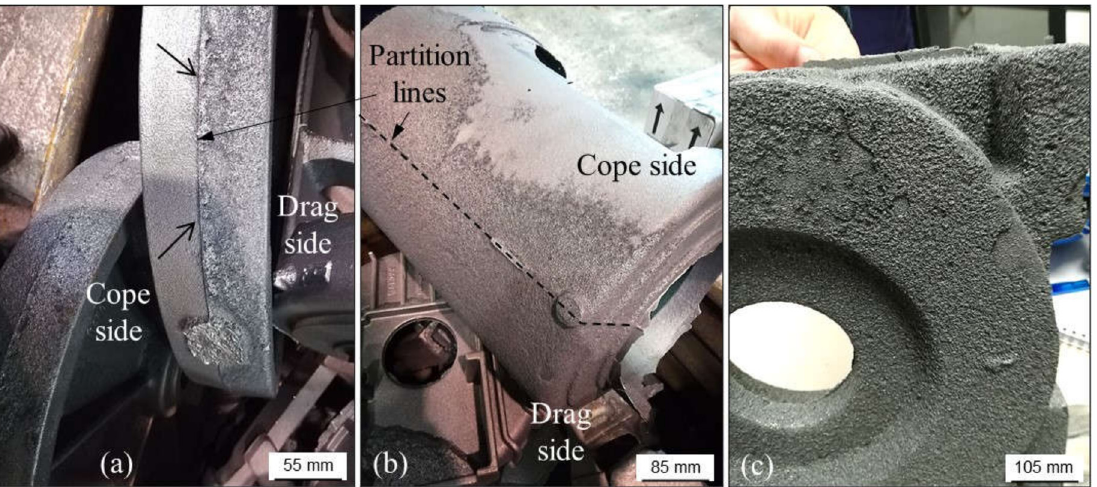
Figure 19. Explosive penetrations in grey iron castings. Notice that the defects appear more intense in the areas defined by drags in ( a , b ). In ( c ) the areas of the casting produced with drags correspond to the areas in the top of the